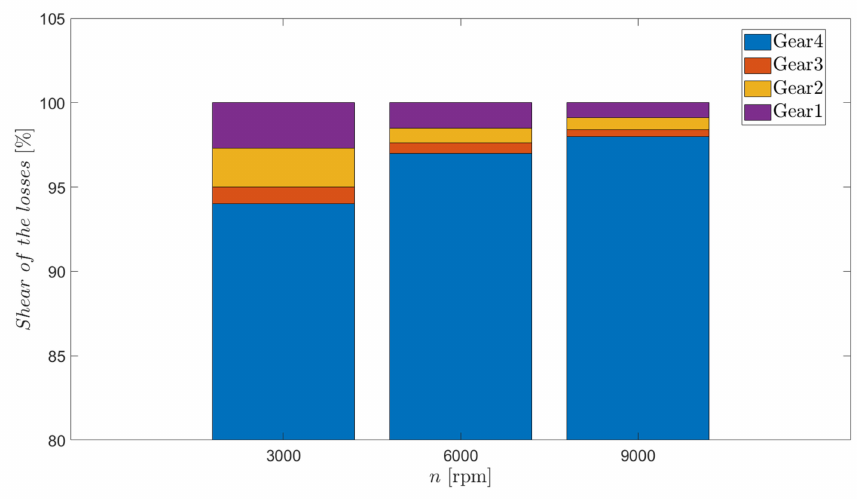
Figure 10. Percentage share of each of the four gears for the no-load losses.